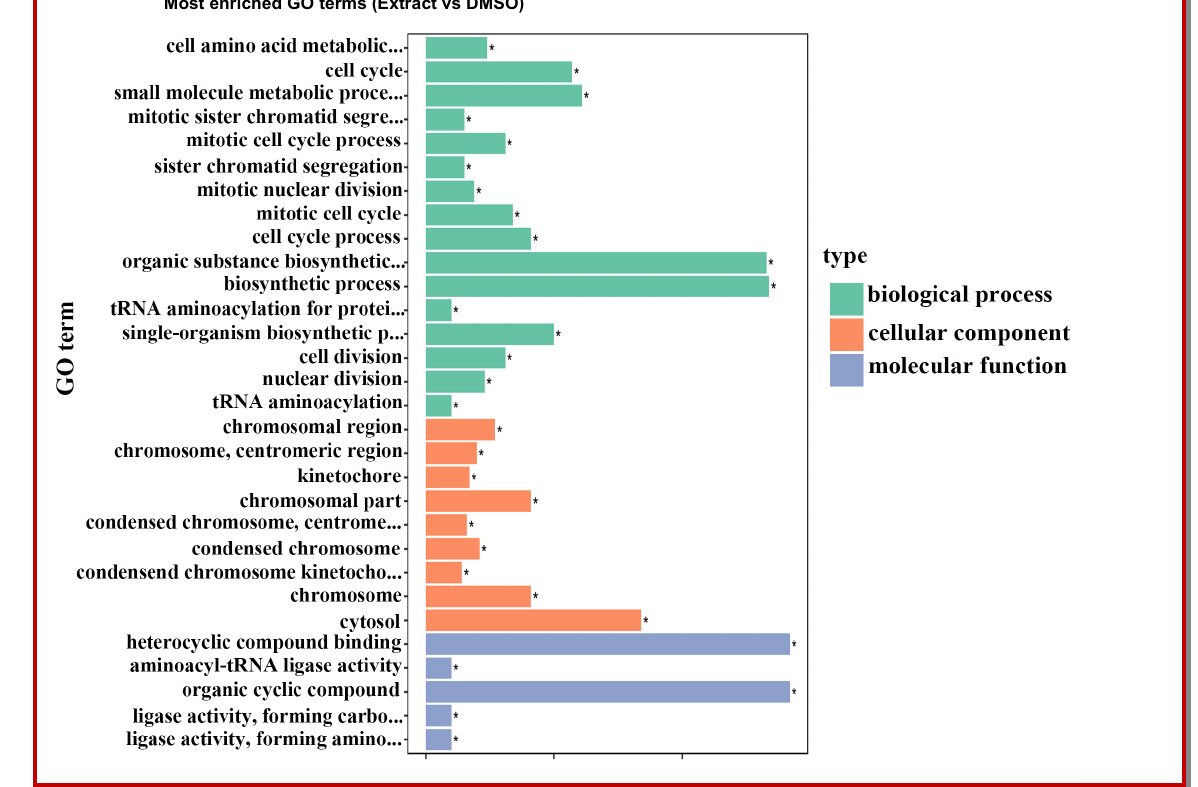
Figure 2: Differential gene expression analysis after treated with P. cocos . Volcano plots of differentially expressed genes between treated lycorine with control (A). GO enrichment analysis of regulated differentially expressed genes in P. cocos -treated cells. His- tograms of the top 30 enriched GO terms. Enriched items were selected with a corrected. p -Value 0.05 (B). KEGG pathway enrich- ment analysis of regulated differentially expressed genes in P. cocos treated-cells (C). Scatter plots of the top 20 enriched KEGG pathway terms. Enriched items were measured by the rich factor, q value (q < 0.05) and the number of